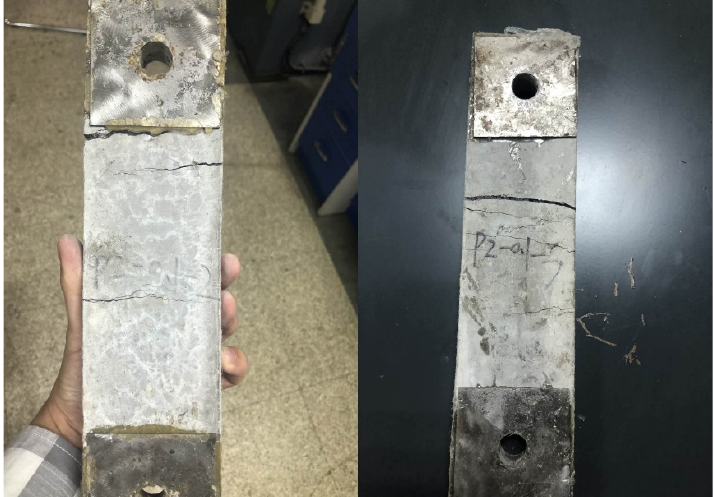
Figure 5. Post-failure specimens of steel grid-PVA fiber reinforced ECC with multiple cracks.